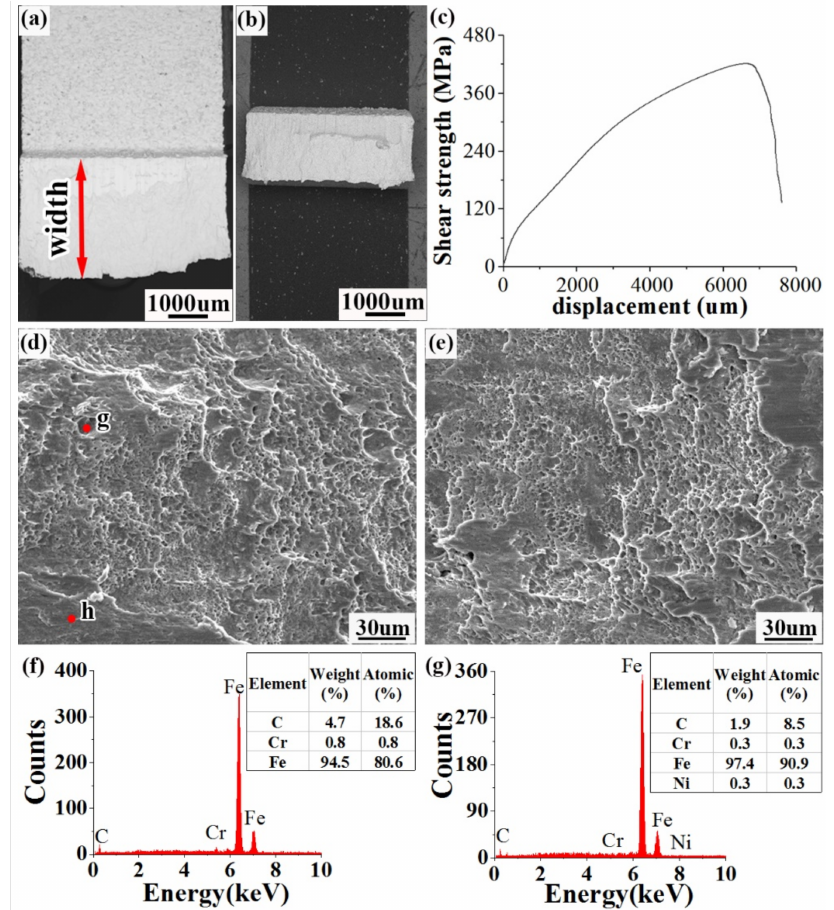
Figure 15. Shear fracture profiles of clad rebars: ( a ) macroscopic profile on the carbon steel side; ( b ) macroscopic profile on the stainless steel side; ( c ) load displacement curve of the shear specimen; ( d ) microscopic profile on the carbon steel side; ( e ) microscopic profile on the stainless steel side; and ( f , g ), EDS point-sweep